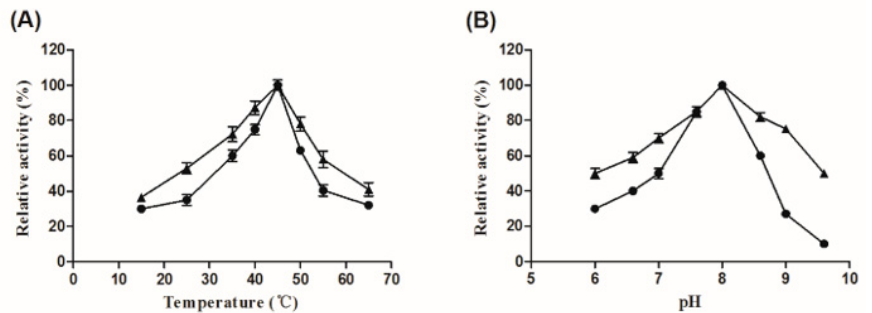
Figure 3. Effect of temperature ( A ) and pH ( B ) on the activity of free (circles) and immobilized (triangles) Aly08. ( A ) Optimal temperature for the activity of free and immobilized Aly08 was determined in 50 mM sodium phosphate buffer (pH 8.0) at diverse temperatures (15–65 °C). ( B ) Optimal pH for the activity of free and immobilized Aly08 was determined at 45 °C. The enzymatic activity of a fresh sample of free or immobilized Aly08 measured at pH 8.0 and 45 °C was defined as 100%.